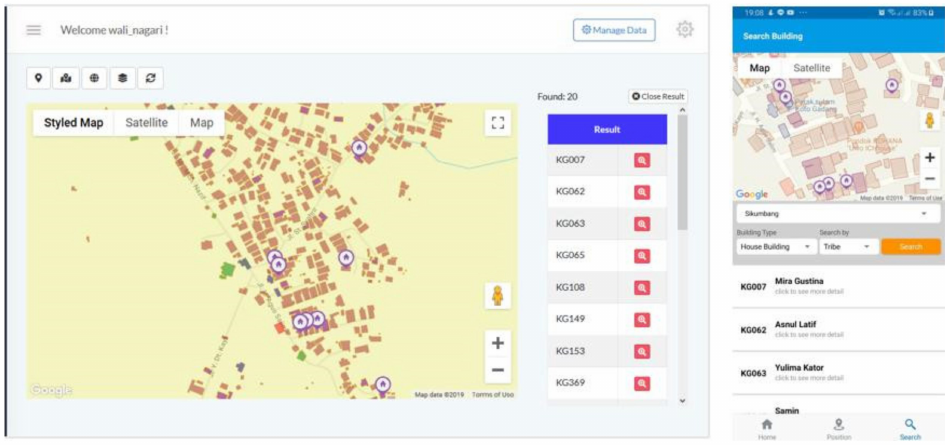
Figure 14. The search results for residents’ houses based on the owners’ tribes in Sikumbang.